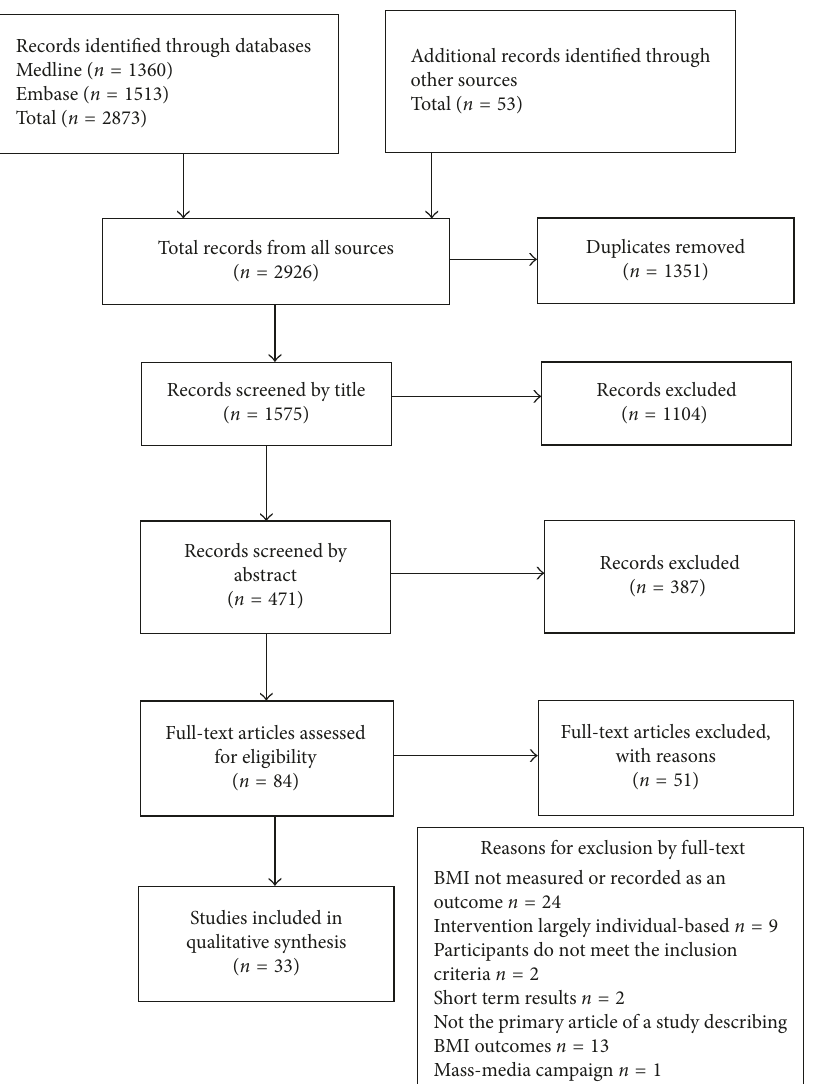
Figure 1: Study identification, screening, and eligibility, guided by